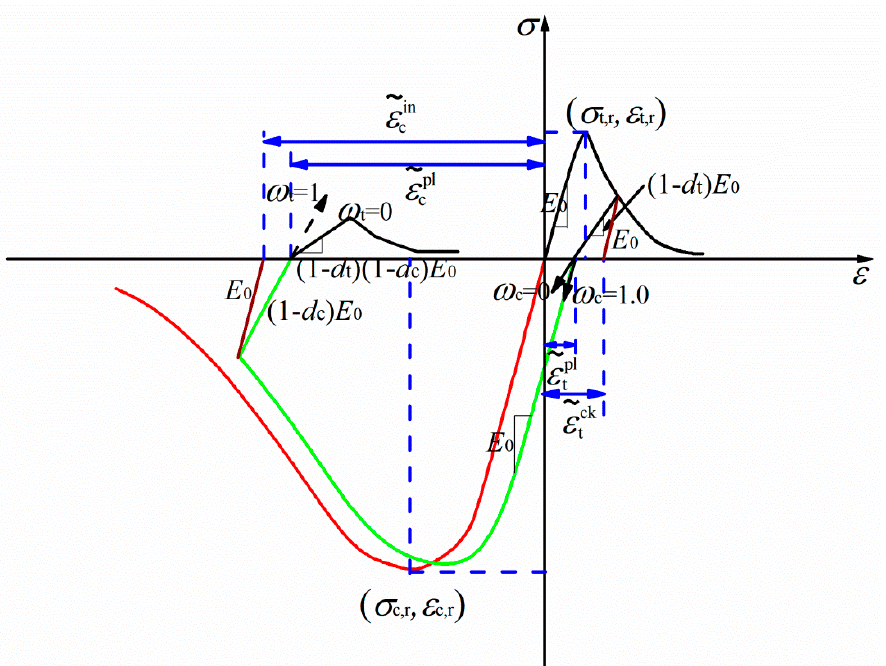
Figure 4. Uniaxial stress–strain curve of concrete. (Note: The curves connected by red and black colours represent the uniaxial stress–strain curves without degradation, while the curves connected by green and black colours represent the damage constitutive model of concrete.)